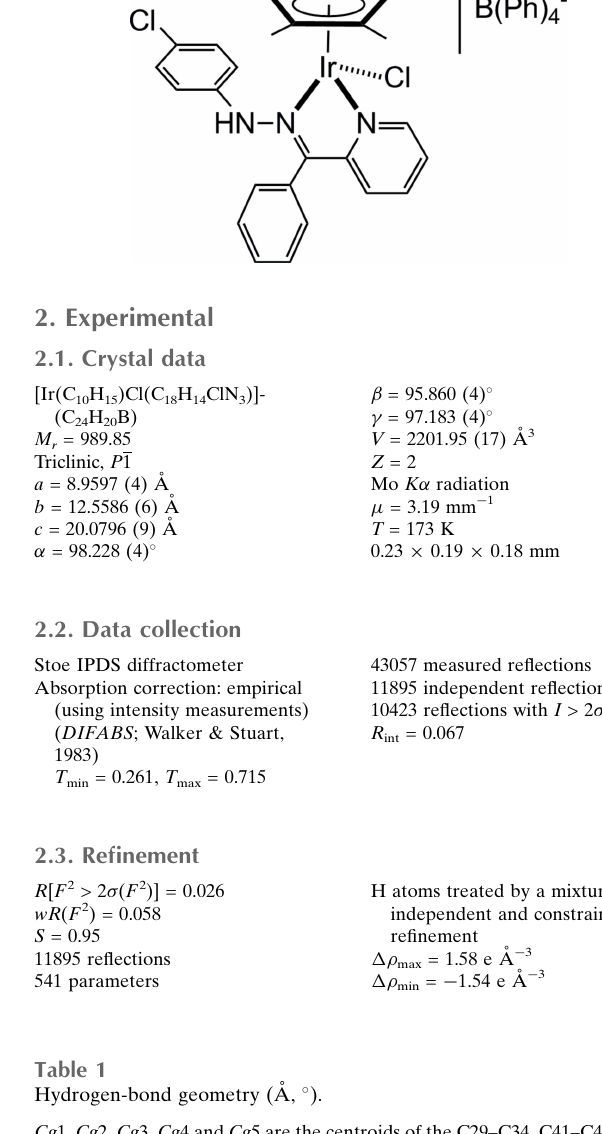
Hydrogen-bond geometry (A˚ , (cid:3)